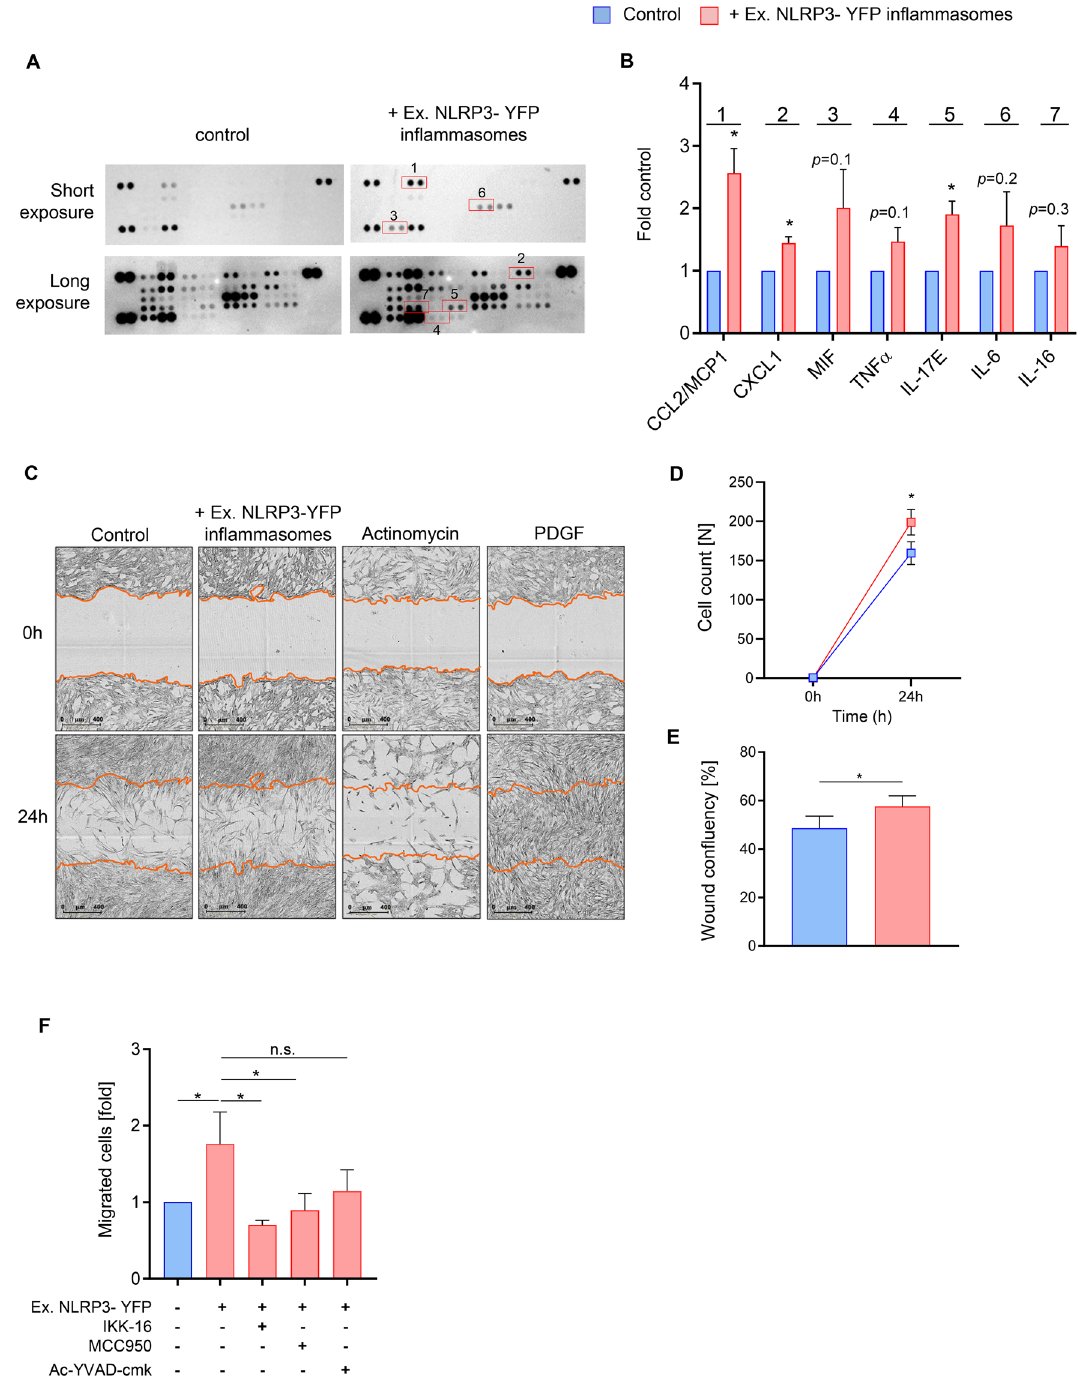
Figure 3. Extracellular NLRP3-YFP inflammasome particles promote release of pro-atherogenic cytokines and cell migration in HCASMC. (A, B) Supernatant of HCASMC (N = 3) after 4 h treatment with extracellular NLRP3-YFP inflammasomes (3:1 particles/ cell) were used for the human proteome profiler cytokine array. Modified cytokines/chemokines were surrounded with a red square and labelled (1–7). Membranes were applied for short and long-time exposure. ( B) Densitometric analysis of the labelled cytokines (1–7) after background subtraction was performed. Data were normalized on supernatant from control cells which was set at 1. ( C) Scratch assay of HCASMC treated with NLRP3-YFP inflammasome particles (3:1 particles/ cell) for 4 h. PDGF (10 ng/ml) and Actinomycin (5 µg/ml) were stimulated for 24 h. Representative images of wounds at the beginning (0 h) and after 24 h are shown. Wounds were automatically acquired within the CO 2 incubator using the IncuCyte ZOOM software package. ( D) Cell count [N] at 0 h and after 24 h within the scratch and ( E) wound confluency [%] was calculated using the IncuCyte ZOOM software. Data are expressed as mean ± SEM and differences between the groups were calculated using unpaired, two-tailed Student´s T-Test (*p < 0.05). ( F) Smooth muscle cell migration was studied in a Boyden chamber by adding NLRP3-YFP inflammasome particles (3:1 particles/ cell) to HCASMC for 4 h and analyzing the migrated cells on the lower side of the insert membrane which was stained with crystal violet and measured at 560 nm in a fluorometer (N = 4–6). Differences between the groups were analysed by One-way ANOVA and uncorrected Fishers LSD post-hoc test (*p <